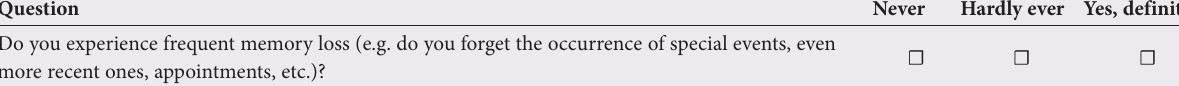
Table 3. Simioni Neurocognitive Symptom Questions [23] Ask the patient the following questions. Each answer should include one of ‘never’, ‘hardly ever’, or ‘yes, definitely’. Any one ‘yes, definitely’ answer equals a positive screen.